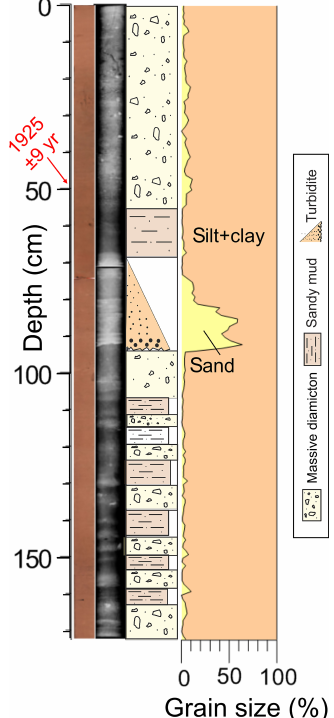
Figure 3. Line scan and X-ray image of sediment core POR13-05, together with grain-size measurements. The top 50cm was dated with the 210 Pb